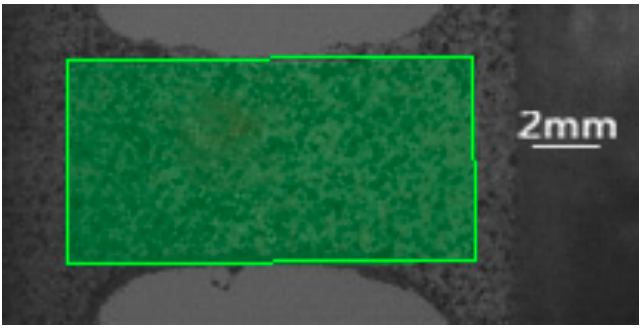
Figure 8. Reading image area of digital-image correlation (DIC) calculation.